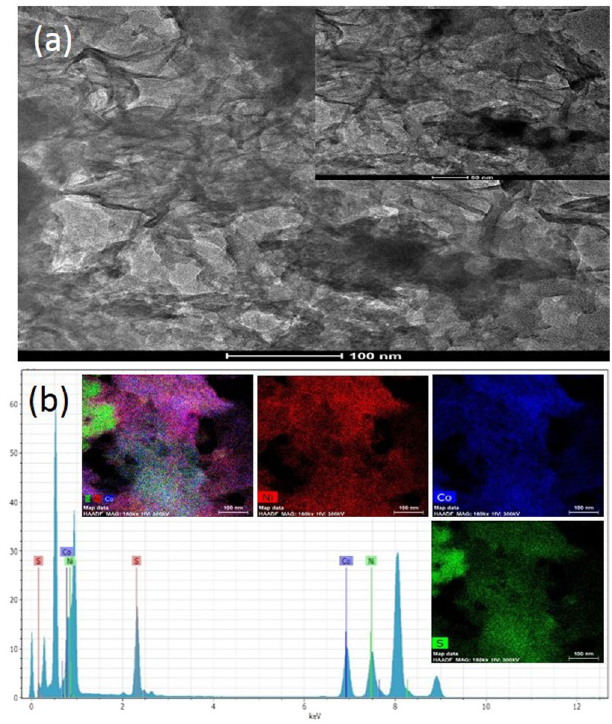
Figure 4. ( a ) TEM, and ( b ) EDS of NiCo 2 S 4 composites at NCS:25 sample, and inset shows the elemental